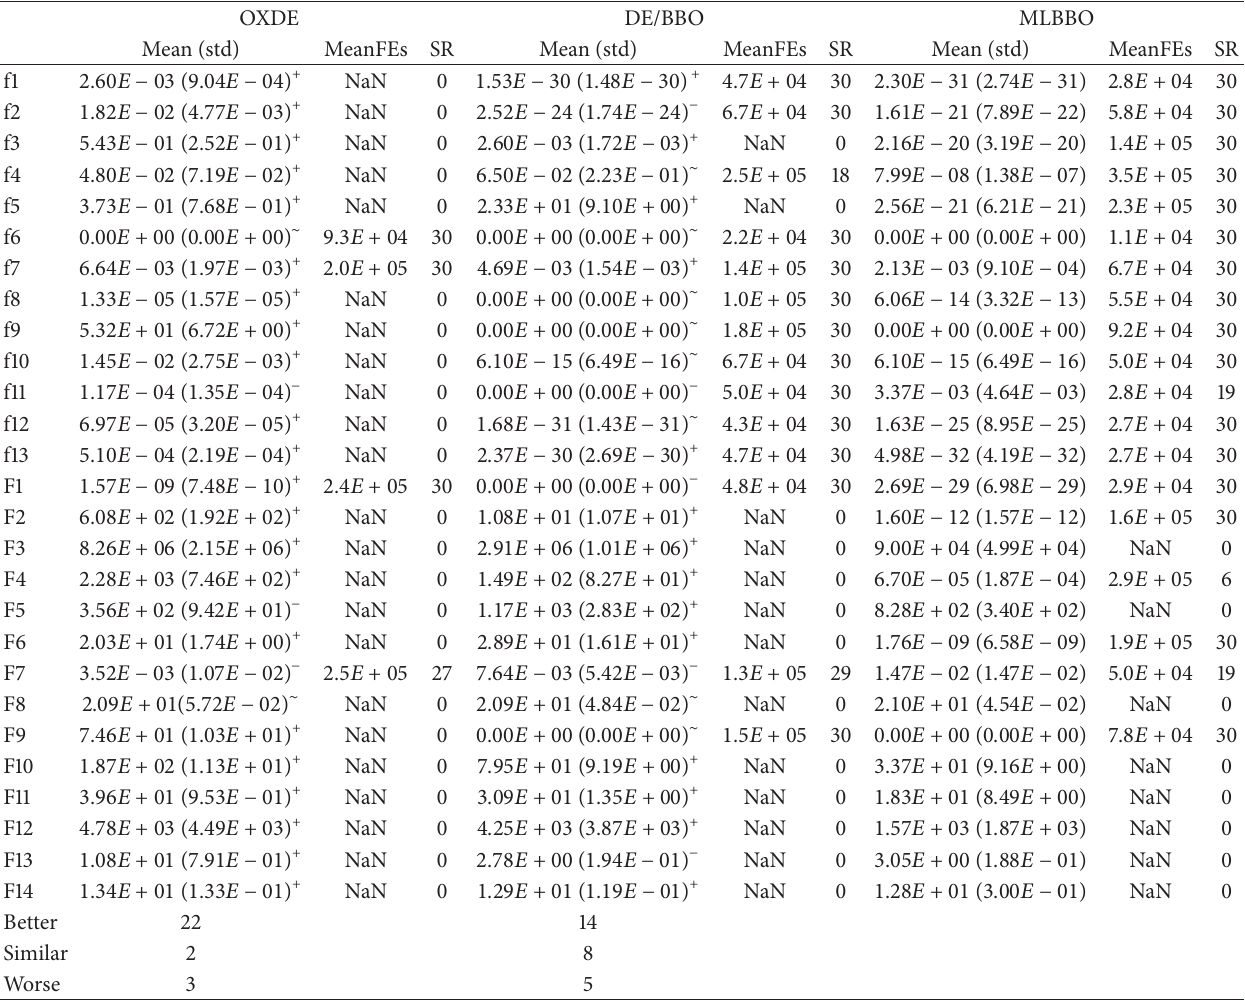
Table 4: Comparisons with hybrid